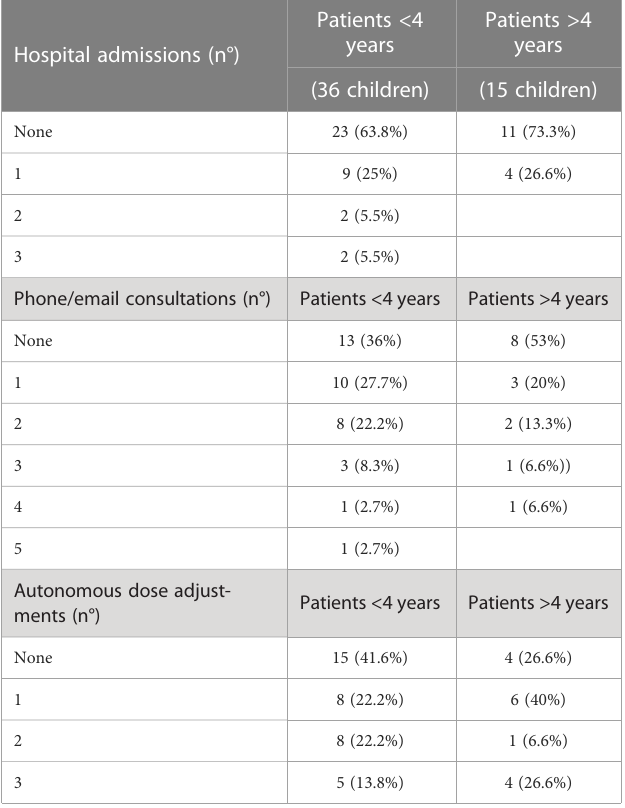
TABLE 1 Measures adopted in the suspicion of adrenal crisis.